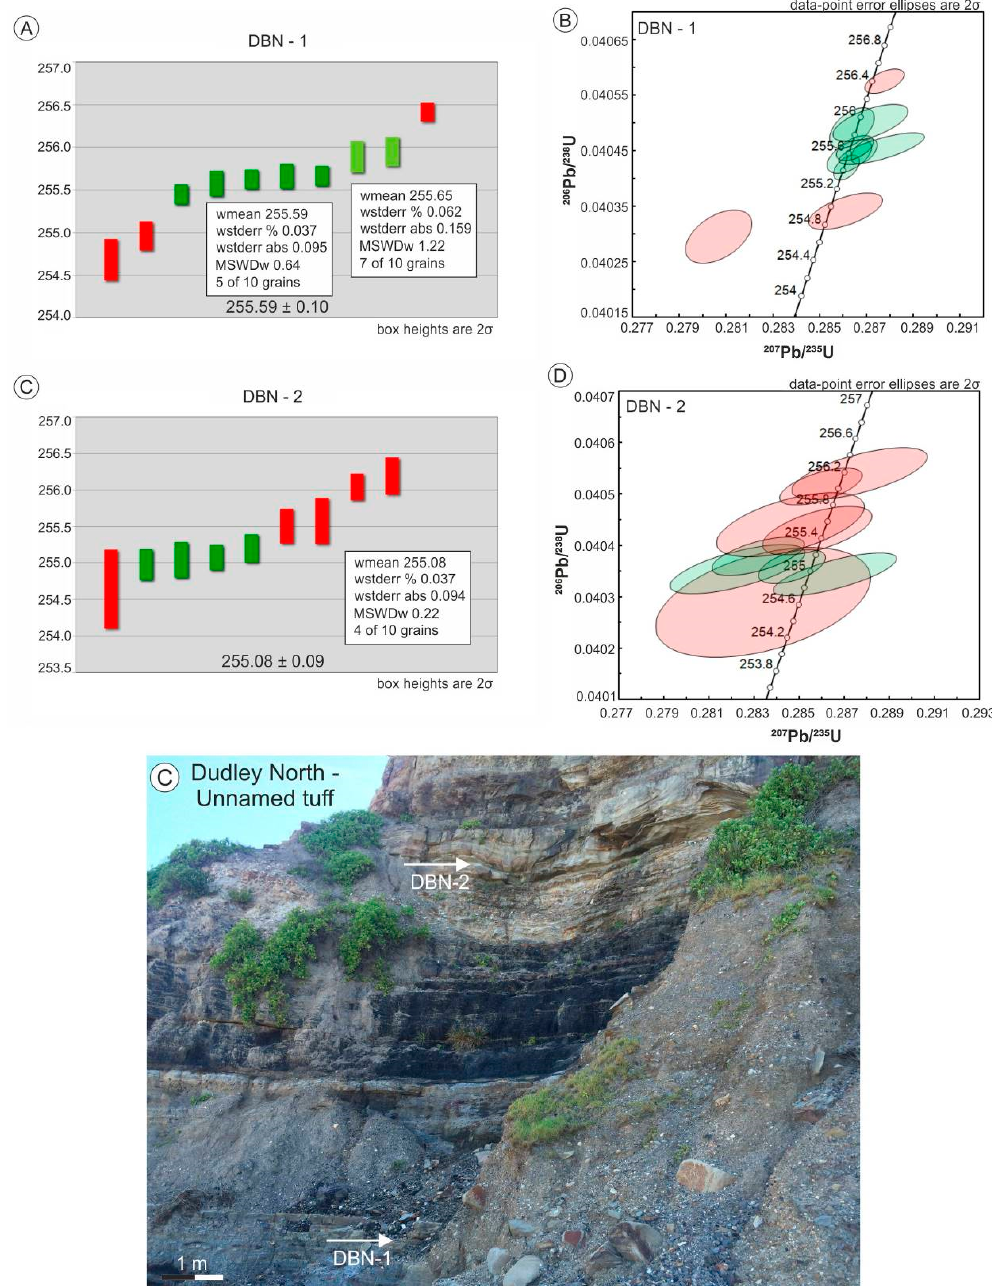
Figure 7. Weighted mean U-Pb CA-IDTIMS results of the selected samples in the study region (northern Sydney Basin). ( A ) to ( D ). Obtained zircon ages and Concordia plots of the tuff marker beds exposed at Dudley north. ( E ) Outcrop photograph of the studied location illustrating the stratigraphic position of the selected tuff samples. Plots illustrate individual zircons (green) used in weighted mean calculation and rejected zircon ages (red). Uncertainties are 2 σ internal.